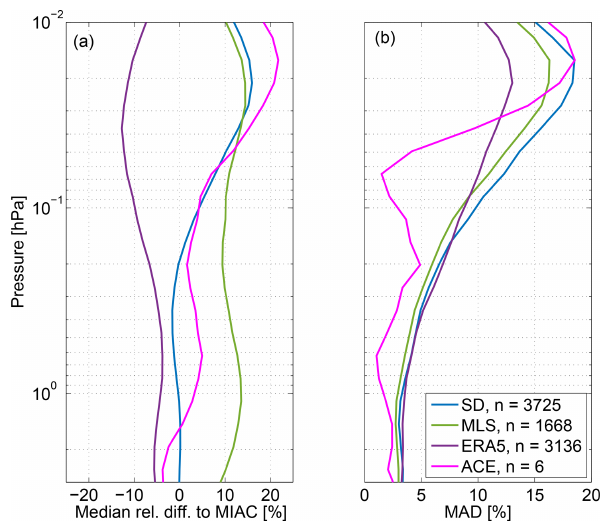
Figure 4. Median of the relative difference of the SD-WACCM, MLS, ERA5 and ACE water vapour profiles and MIAWARA-C measurements at Ny-Ålesund (a) . Median absolute deviation of the relative difference profiles (b) . In the legend n indicates the number of coincident MIAWARA-C